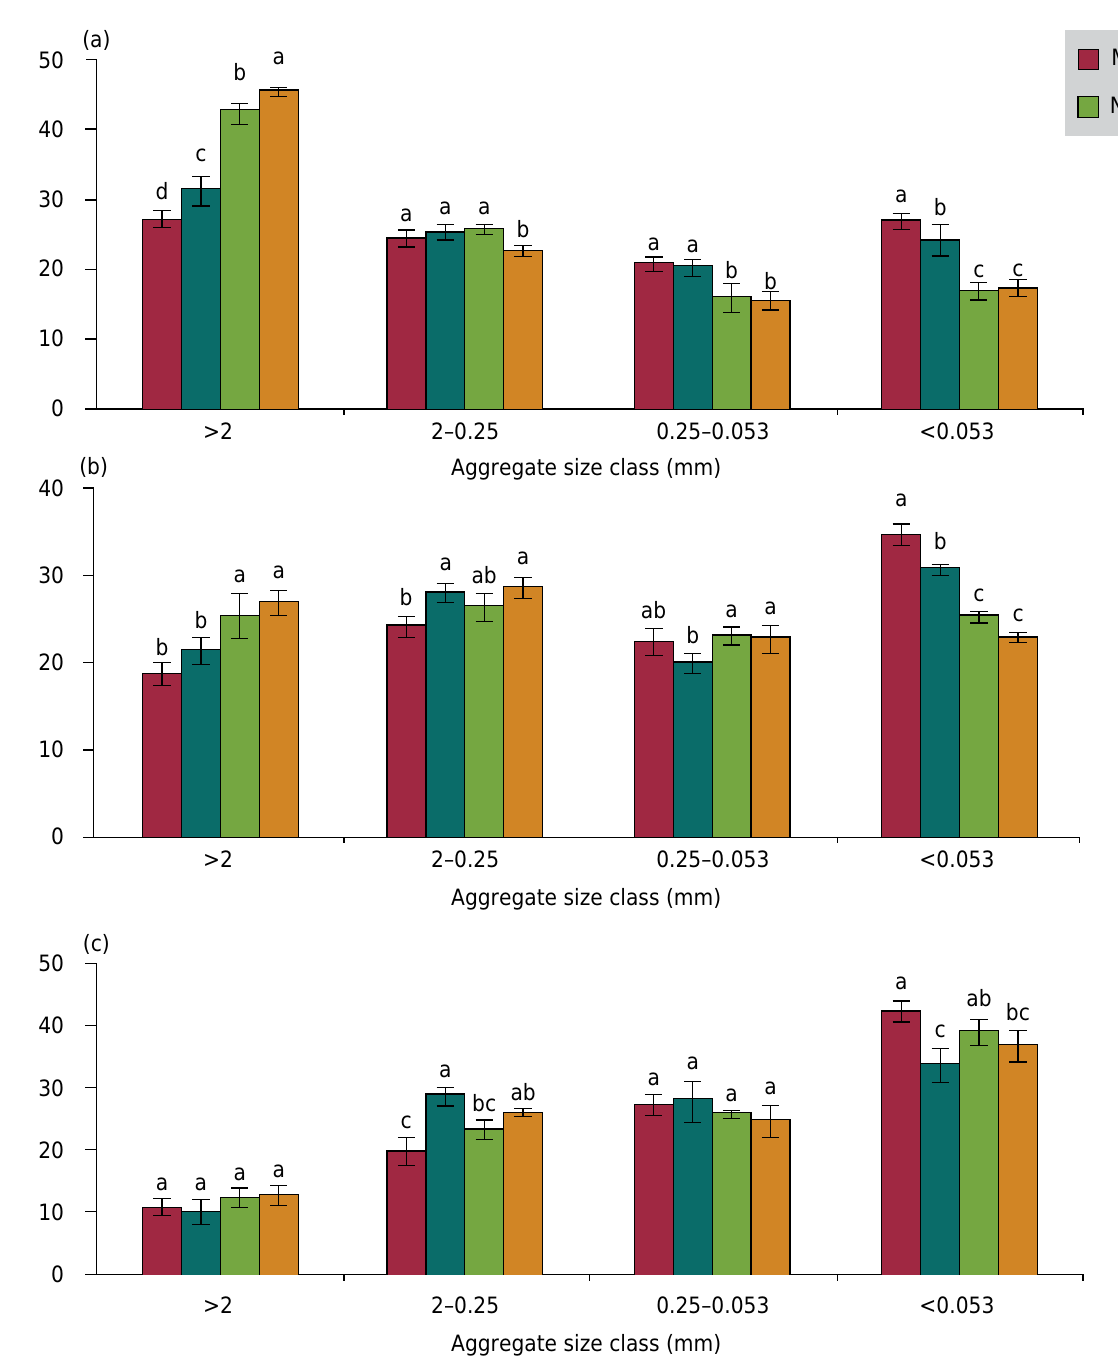
Figure 1. Distribution (%) of water-stable aggregates with different sizes in different soil layers as influenced by tillage treatments. (a) 0.00-0.05 m; (b) 0.05-0.20 m; (c) 0.20-0.30 m. MP-S: moldboard plow without straw; MP+S: moldboard plow with straw; NT-S: no-tillage without straw; NT+S: no-tillage with straw. Error bars represent standard errors of the means (n = 3). Different lower-case letters within an aggregate size indicate significant differences between treatments according to Duncan’s test